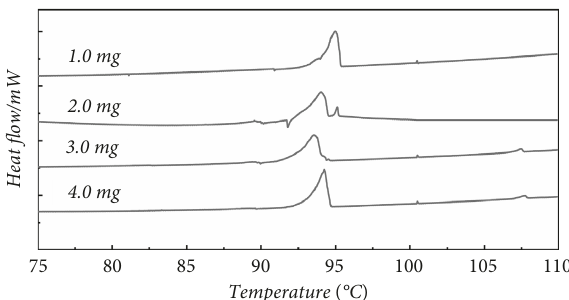
Figure 1: DSC curves of Benzil’s samples without thermal history